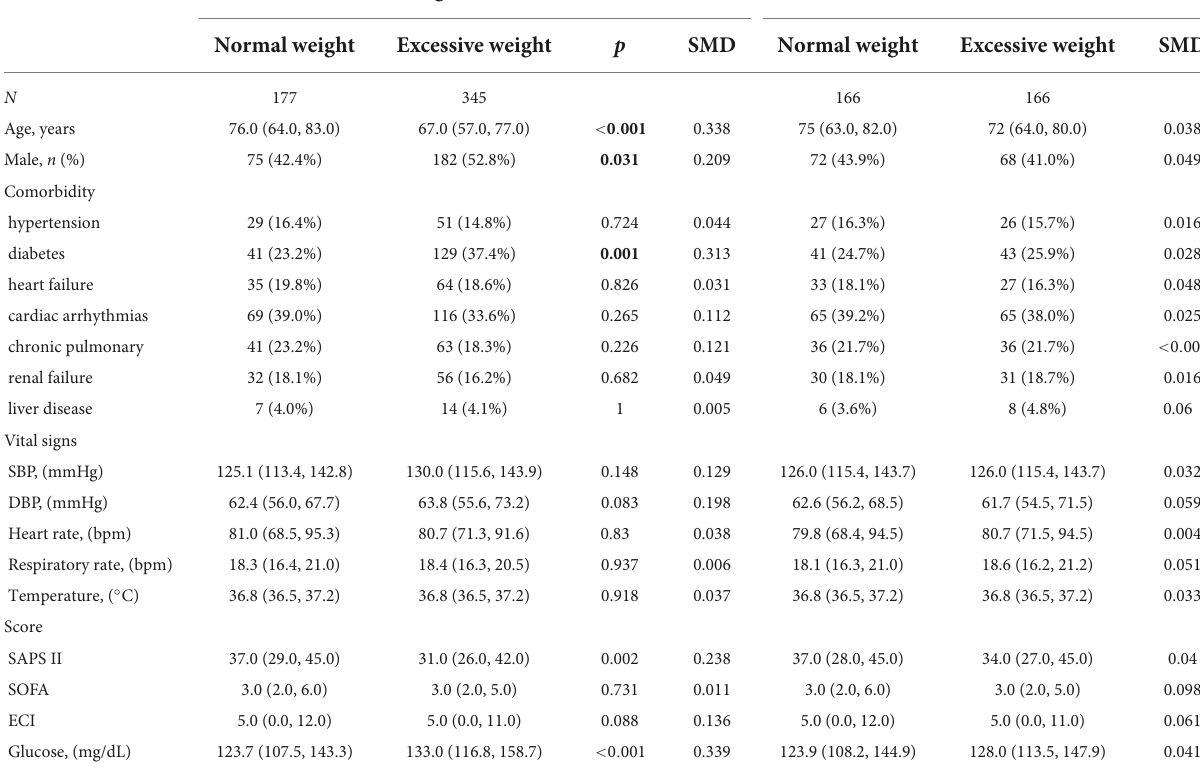
TABLE 1 Characteristics of the study population stratified into two classifications of body mass index (BMI).